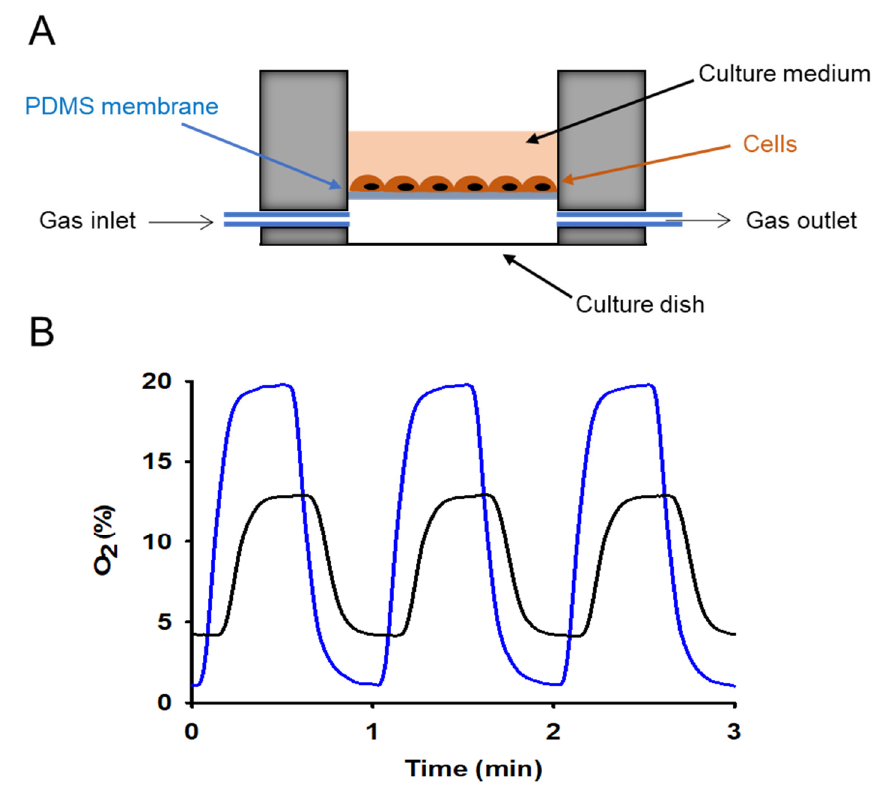
Figure 1. Experimental in vitro system for cellular exposures to constant or variable oxygen concen- trations. ( A ) schematic view of the cell culture setting to apply controlled intermittent hypoxia (IH) to cultured cells (see text for explanation). ( B ) actual oxygen concentration measured on top of the membrane (cell culture level) when applying IH with different magnitudes (1–20% O 2 (blue line) and 4–13% O 2 (black line) at a frequency of 60 cycles/h. Reprinted with permission from Ref. [11]. 2017. American Physiological Society